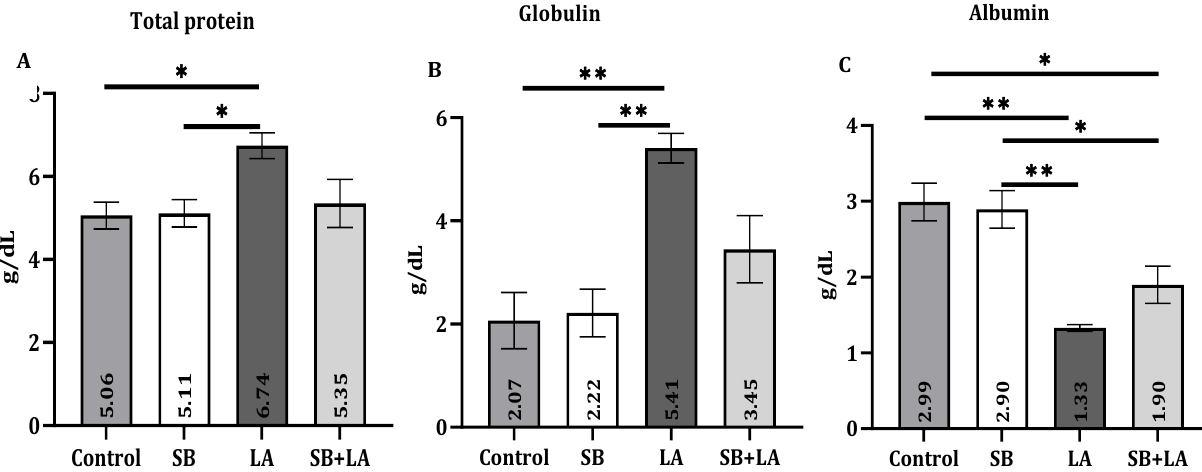
Figure 2. Effect of sodium butyrate, lead acetate, and their combination on ( A ) serum total protein (g/dL), ( B ) serum albumin (g/dL), and ( C ) serum globulin in adult female rats. Mean±SEM, n=10. Control, rats received only drinking water; SB, rats orally received sodium butyrate at 200 mg/kg BW; LA, rats orally received lead acetate at 50 mg/kg BW; SB+LA, rats orally received both sodium butyrate at 200 and lead acetate at 50 mg/kg BW. * P ≤0.05, ** P ≤0.01, *** P ≤0.001, # P ≤0.000